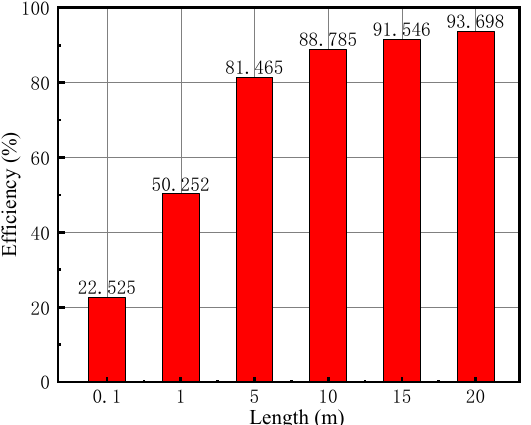
Figure 6. Length of transfer structure versus transmission efficiency.